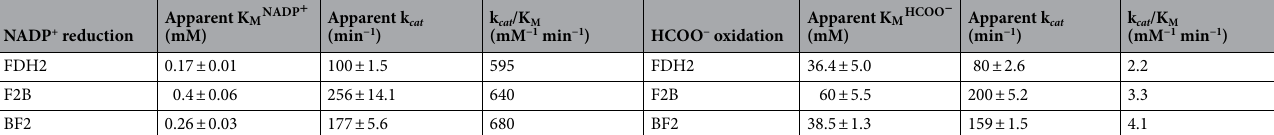
Table 3. Kinetic parameters measured for individual FDH2 and fusions during NADP + -dependent HCOO - oxidation and HCOO − -dependent NADP + reduction. The kinetic parameters with the appropriate standard errors were calculated using the software Origin 9 and fitted to the Michaelis–Menten model.